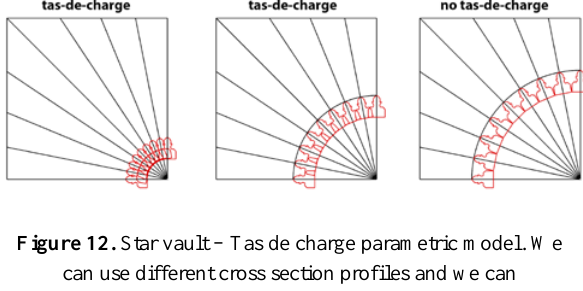
Figure 12. Star vault – Tas de charge parametric model. We can use different cross section profiles and we can parametrically define the extrusion lines geometry and placement in relation to the case